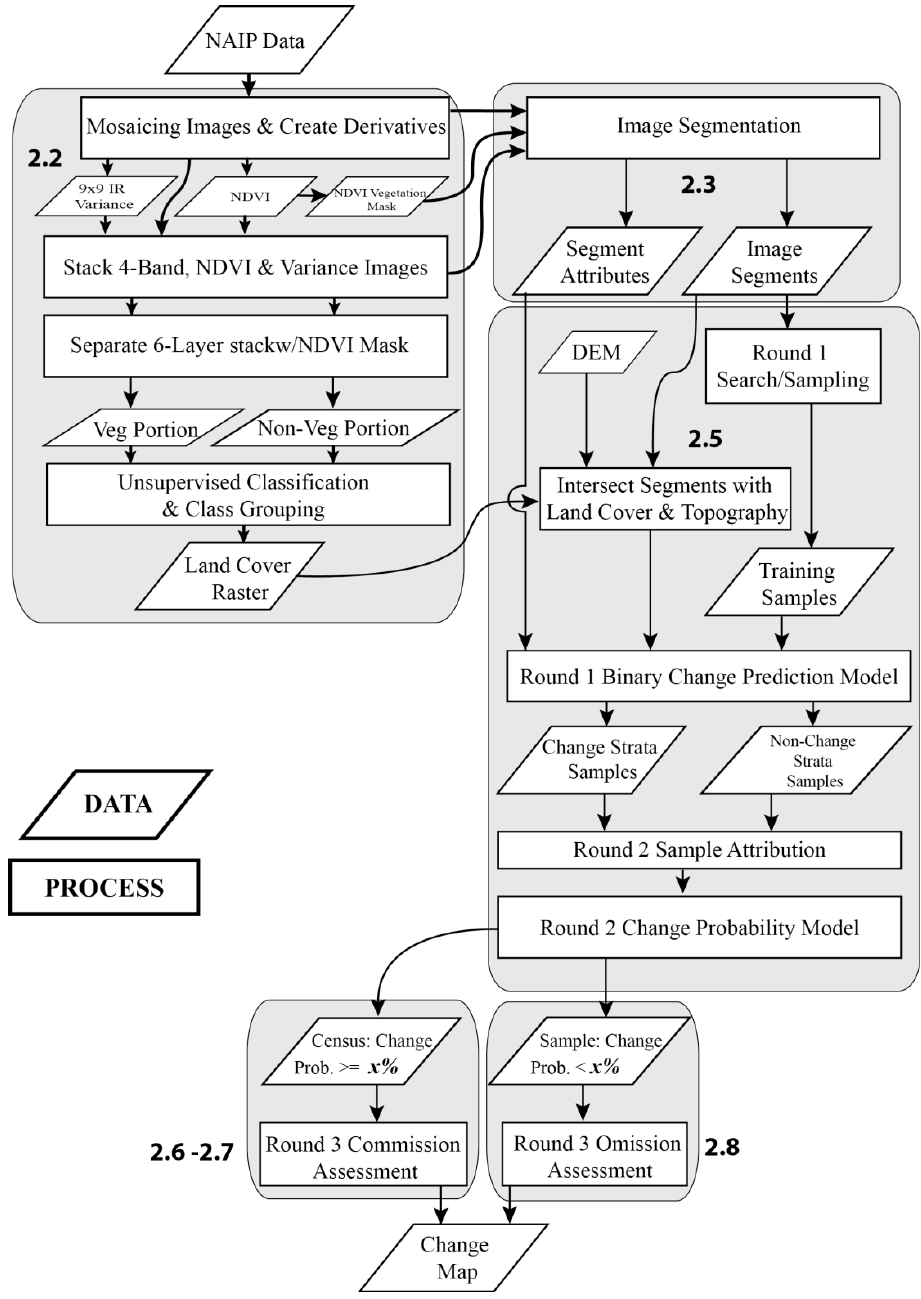
Figure 3. Flowchart of overall change mapping methodology. Shaded boxes represent sections within the methods with the section number bolded. The x represents the change